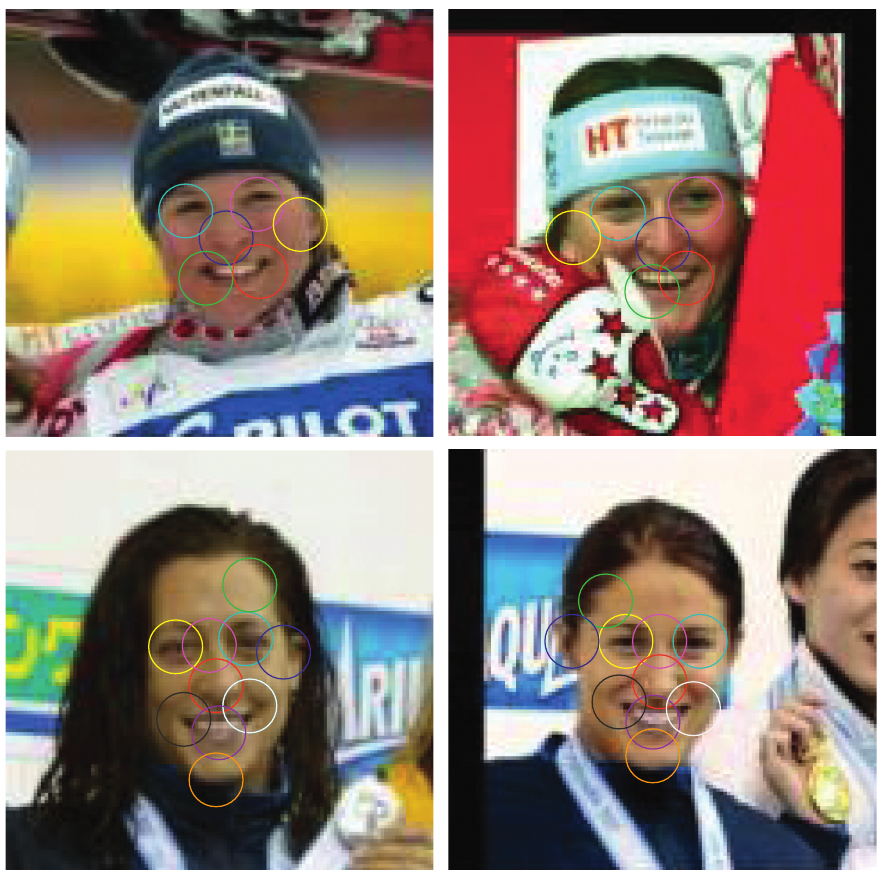
Figure 18: Face image FE and matching. Different colored circles in the same picture indicate different extracted features, and the same color in different pictures in the same group indicates matching similar features.